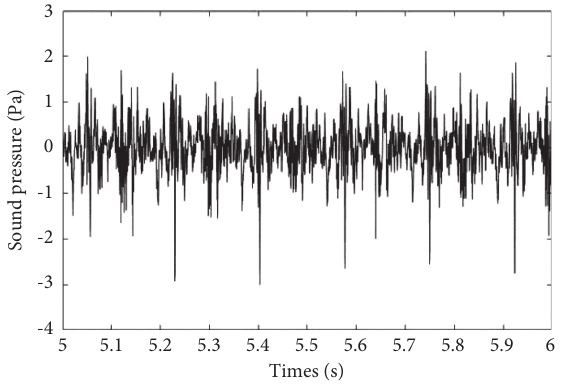
Figure 20: CEEMDAN reconstruction signal.